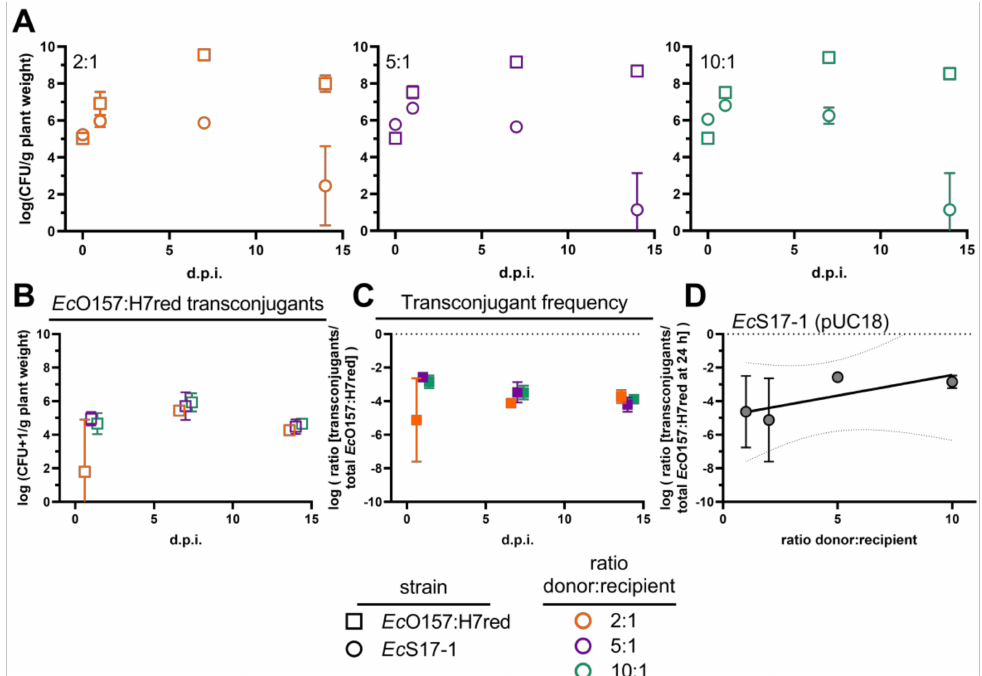
Figure 5. Conjugation dynamics of the mobilisable plasmid pUC18 after inoculating different densities of donors. ( A ) Pop- ulation developments after co-inoculation of different ratios of the donor Ec S17-1 (circles) harbouring pUC18 with the recipient Ec O157:H7red (squares) onto gnotobiotic A. thaliana after 1, 7, and 14 d.p.i. The initial recipient inoculation density remained constant, whilst Ec S17-1 donors were inoculated at different densities, resulting in donor/recipient ratios of 2:1 (left, orange), 5:1 (middle, purple), and 10:1 (right, green). ( B ) Population development of transconjugant Ec O157:H7red after co-inoculation with different densities of donor Ec S17-1 (pUC18) onto gnotobiotic A. thaliana after 1, 7, and 14 d.p.i. ( C ) Frequency of Ec O157:H7red transconjugants in the recipient population after co-inoculation with different densities of donor Ec S17-1 (pUC18) onto gnotobiotic A. thaliana after 1, 7, and 14 d.p.i. ( D ) Transconjugant frequencies of different donor/recipient ratios after 24 h. No significant differences in the conjugation efficiency after treatments with different Ec S17-1 donor concentrations could be detected, however, the variation within treatments was lower at high donor densities. A linear regression was fitted (r 2 = 0.61, broken lines 95% confidence intervals of the linear regression). Error bars represent the standard deviation of the mean.